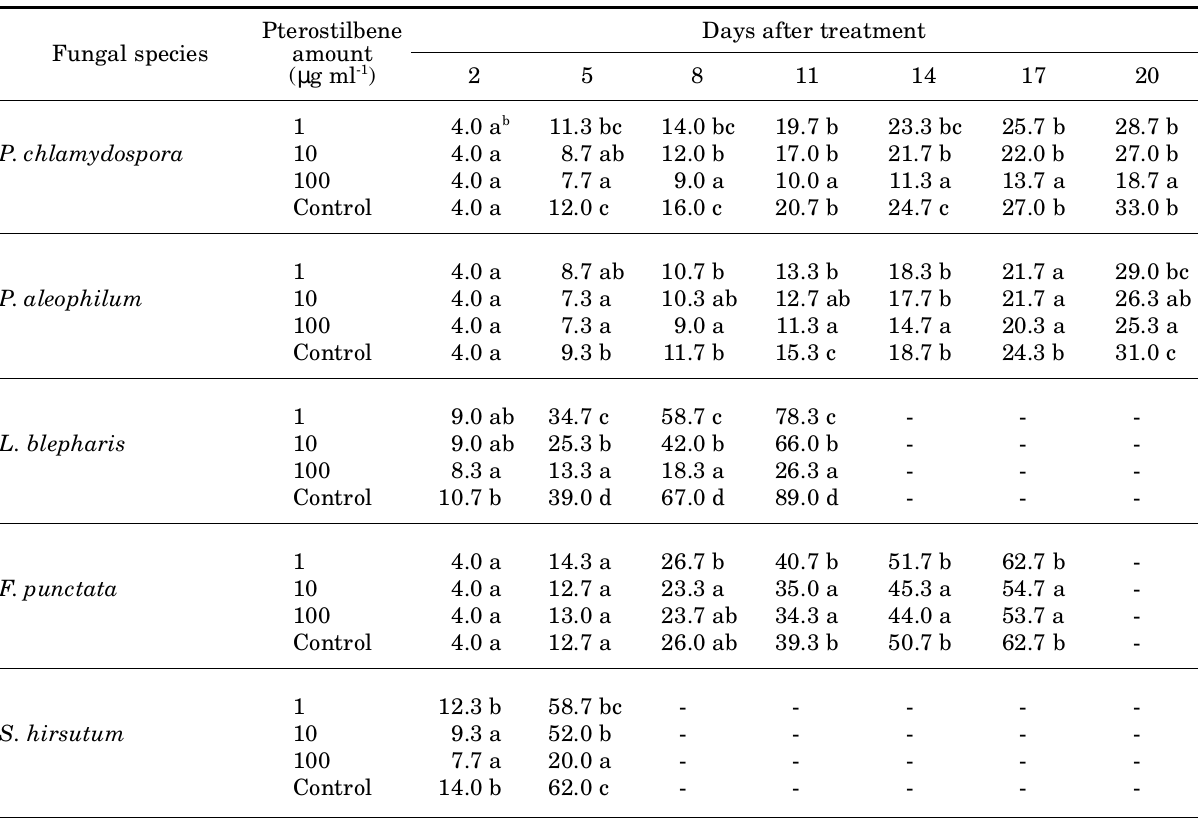
Table 2. Mycelial growth a of fungi with different amounts of pterostilbene in the medium. Mycelial growth (mm) is expressed as colony